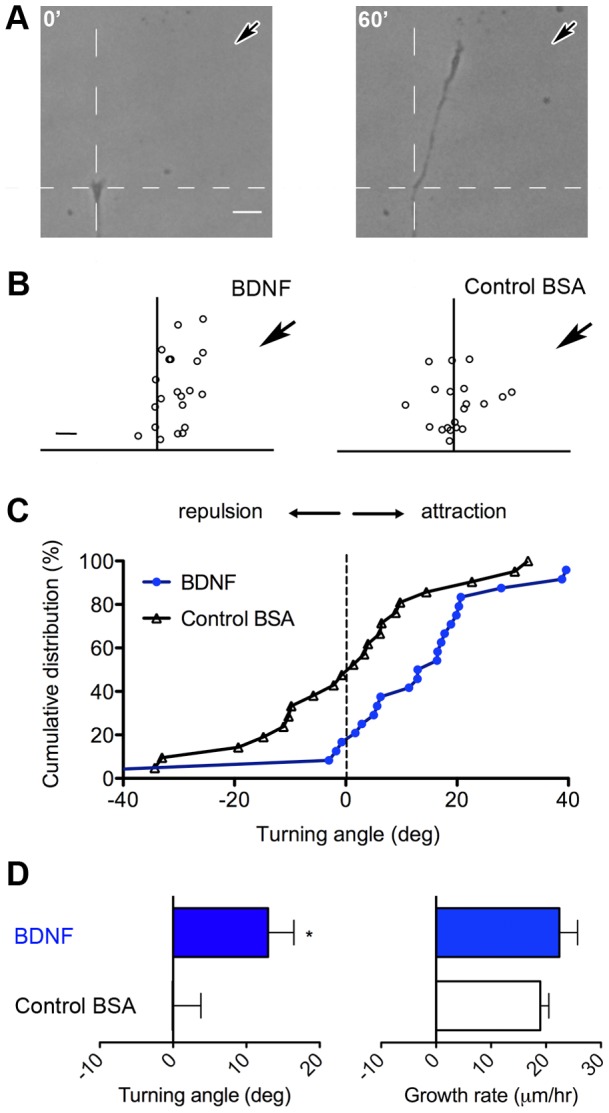
Zebrafish spinal neurons are attracted to an exponential gradient of BDNF.(A) Representative depiction of zebrafish axon turning to a BDNF gradient in vitro. (B) Final growth cone endpoints of turning assays. (C) Cumulative distribution and (D) mean of all turning angles to a BDNF gradient vs. control solution. Application of BDNF gradient causes no change in neurite growth rate. Scale bar, 10 µm. *, p<0.05.